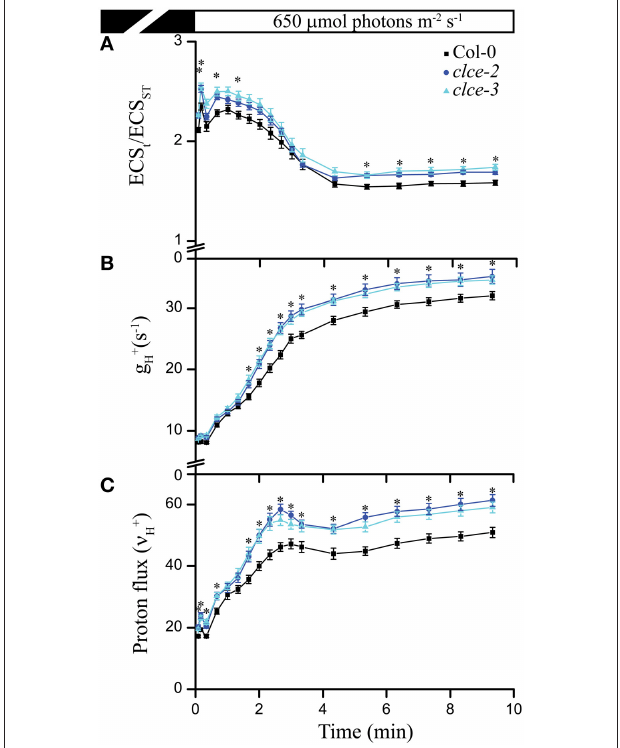
FIGURE 3 | Proton motive force, H + conductivity through ATP synthase, and H + flux. Electrochromic shift measurements (ECS) were performed on 30min dark-adapted wild-type and mutant plants. (A) Total proton motive force (ECS t normalized to ECS ST ) induction kinetics during illumination at the given light intensity. (B) ATP synthase conductivity (g H + ), and (C) proton flux ( ν H + ) were calculated from ECS decay kinetics as described in Section Materials and Methods. The plotted data are means ± SEM ( n = 8 –9 plants). Asterisks indicate statistically significant differences according to ANOVA ( P < 0.05